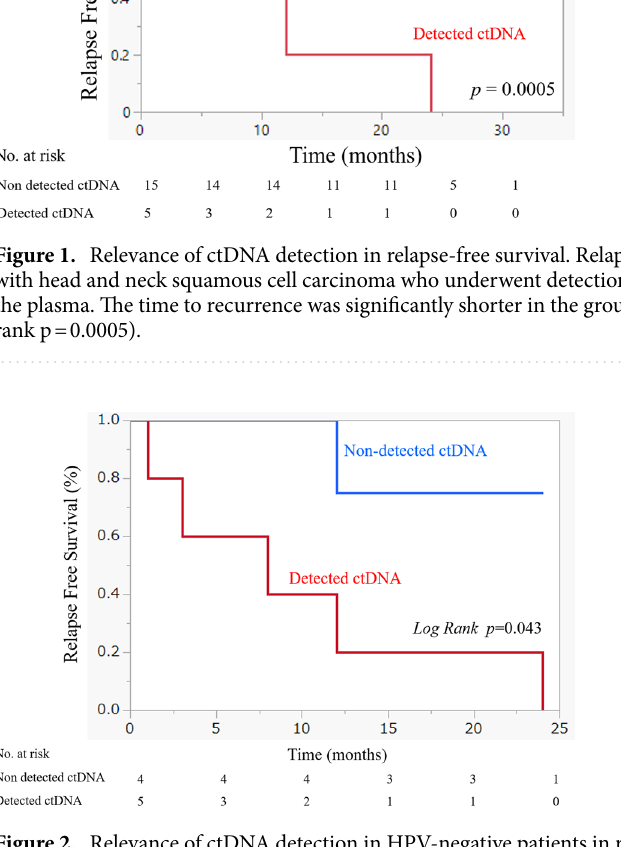
Figure 2. Relevance of ctDNA detection in HPV-negative patients in relapse-free survival. Relapse-free survival (RFS) rate of patients with HPV-negative head and neck squamous cell carcinoma who underwent detection of